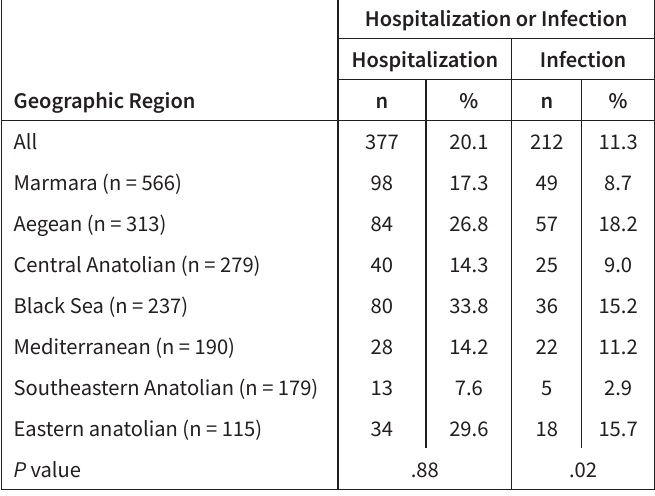
Table 4. The Rate of the Hospitalizations and Infections Across Different Regions